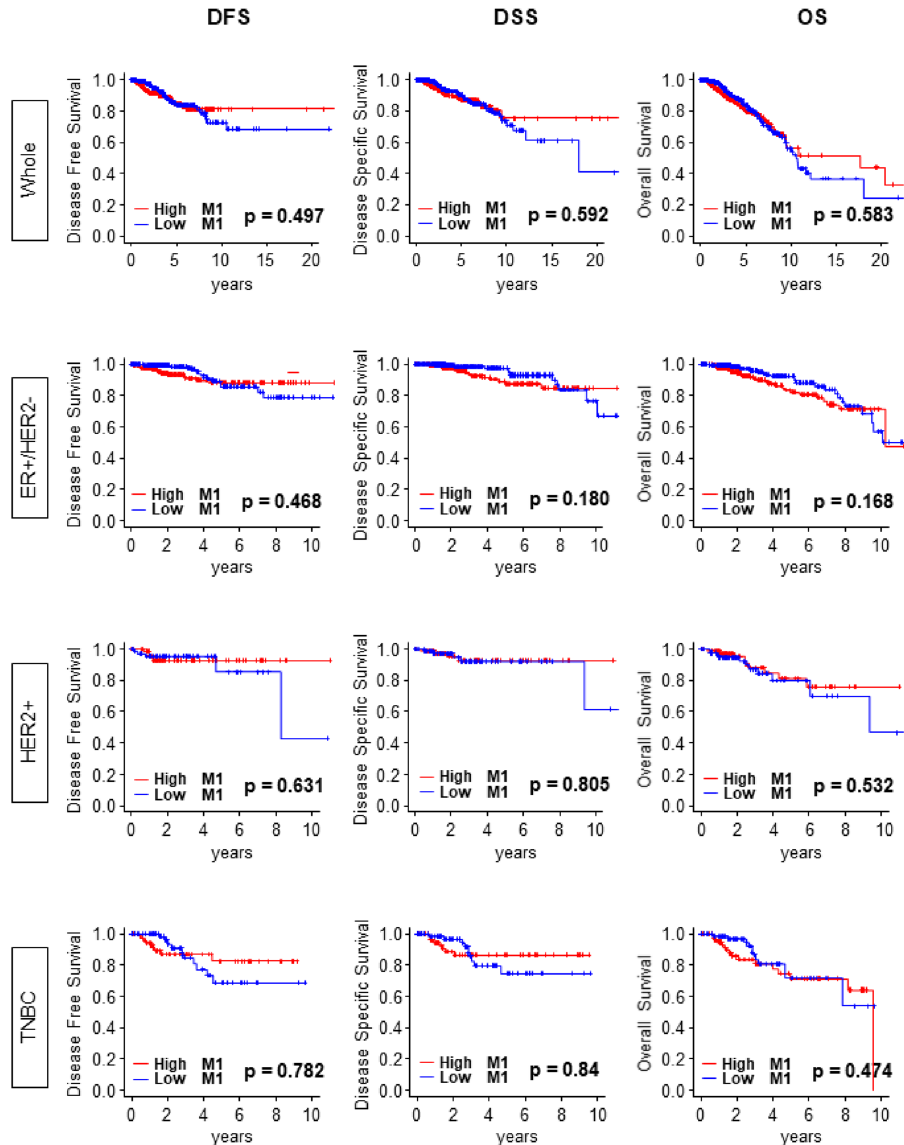
Figure 1. Kaplan Meier survival analysis of DFS, DSS, and OS did not demonstrate the survival benefit of “M1” high tumors over “M1” low tumors. DFS (Whole, n = 924, High = 466, low = 458, Hazard ratio (HR) 1.16 (95% Confidence interval [CI] 0.76–1.78); ER+/HER2−, n = 506, High = 253, Low = 253, HR 1.29 (CI 0.64–2.59); HER2+, n = 151, High = 81 Low = 70, HR 0.74 (CI 0.21–2.56); TNBC, n = 144, High = 73, Low = 71, HR 0.88 (CI 0.36–2.17). DSS (Whole, n = 1045, High = 526, low = 519, HR 1.13 (CI 0.73–1.74); ER+/HER2−, n = 572, High = 287, Low = 285, HR 1.67 (CI 0.78–3.56); HER2+, n = 173, High = 87, Low = 86, HR 0.85 (CI 0.22–3.21); TNBC, n = 153, High = 76, Low = 77, HR 0.91 (CI 0.35–2.35). OS (Whole, n = 1064, High = 532, Low = 532, HR 1.10 (CI 0.79–1.51); ER+/HER2−, n = 578, High = 289, Low = 289, HR 1.45 (CI 0.85–2.48); HER2+, n = 175, High = 88, Low = 87, HR 0.75 (CI 0.31–1.83); TNBC, n = 159, High = 80, Low = 79, HR 1.33 (CI 0.61–2.88). M1, “M1” macrophage; DFS, disease free survival; DSS, disease specific survival; OS, overall